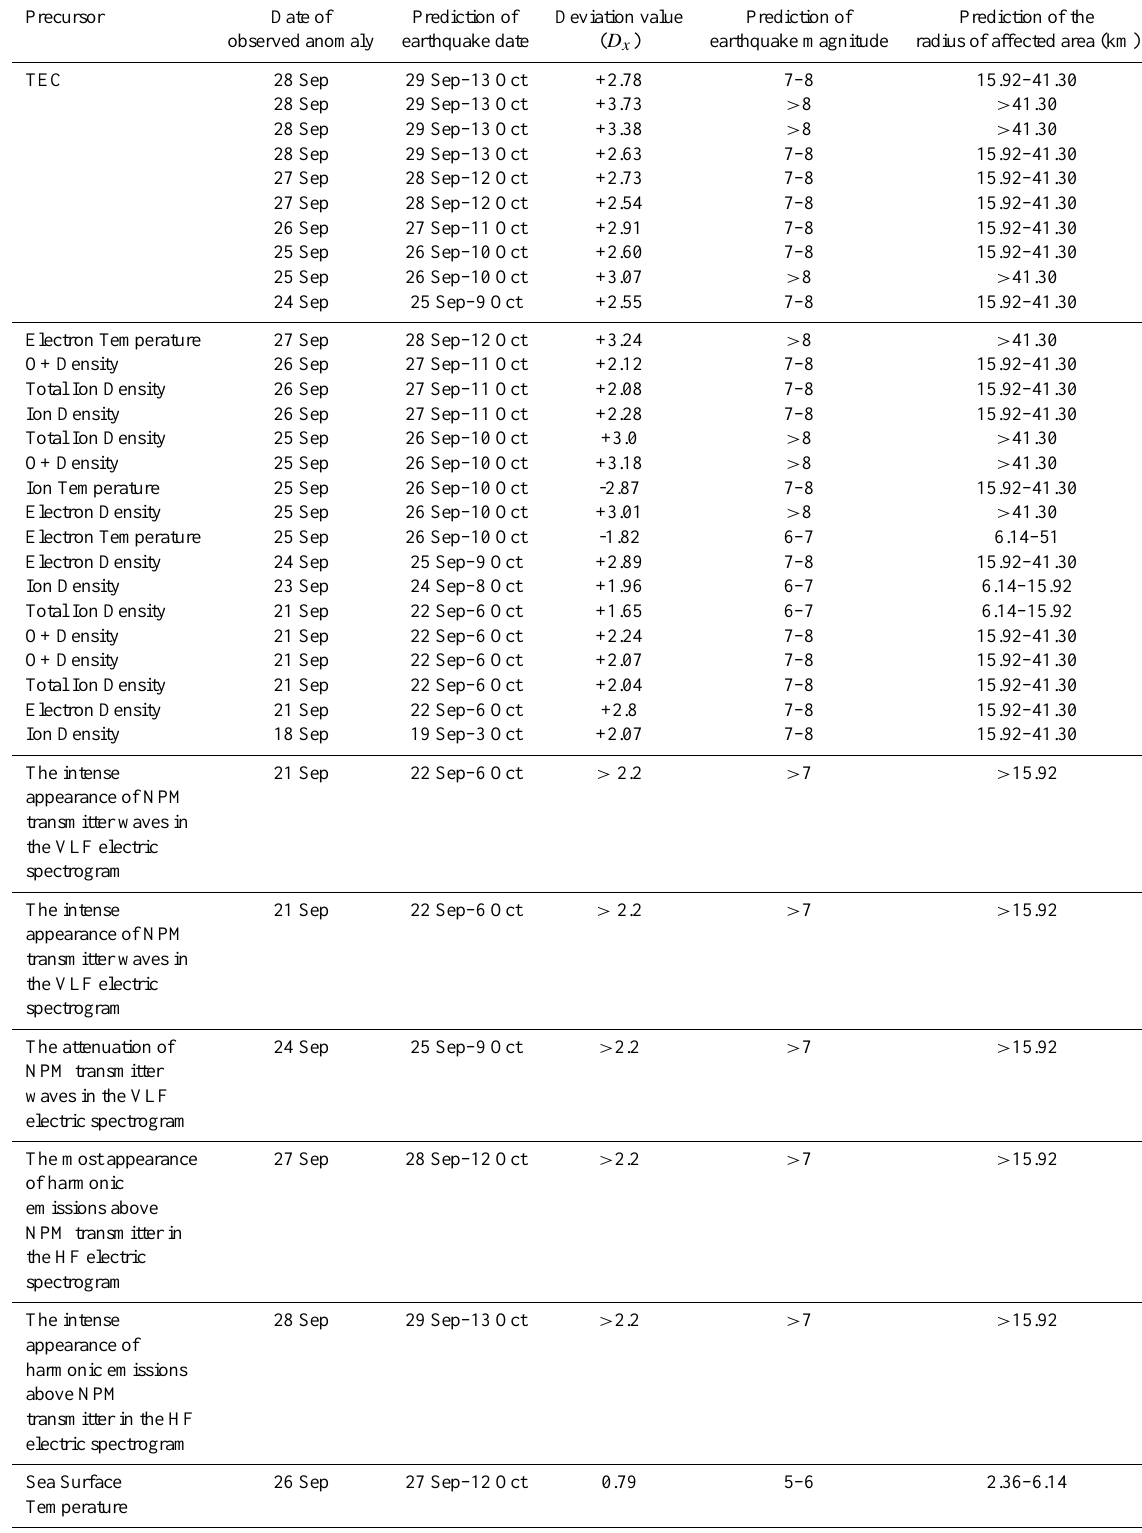
Table 4. Different precursors concerning Samoa earthquake (Akhoondzadeh,